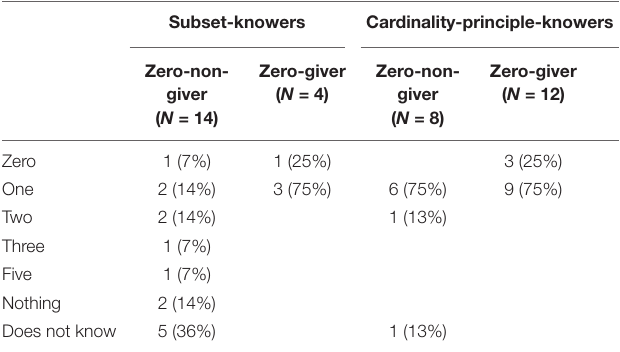
TABLE 2 | ANOVA results of the operations tasks. TABLE 3 | Proportion of different replies to “what is the smallest number?” in the four groups of number knowledge at the beginning of the session.